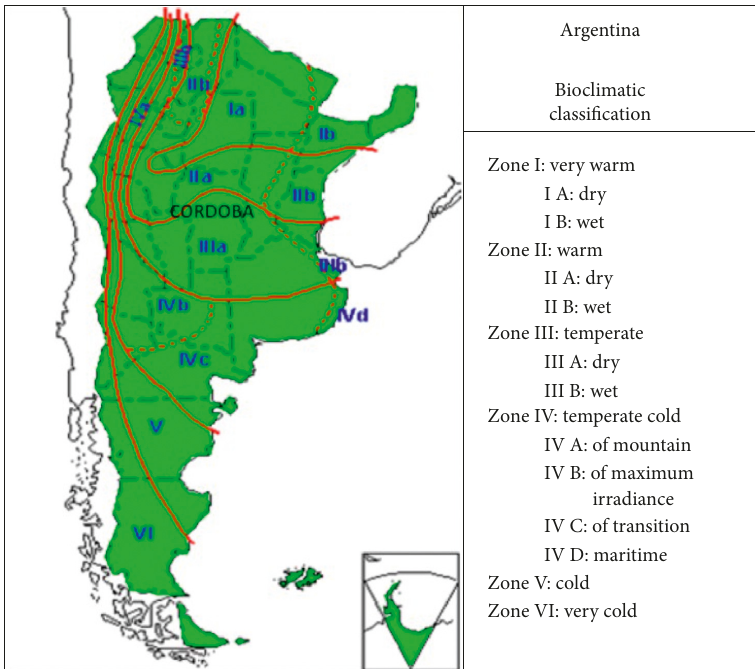
Figure 2: Bioclimatic classification of the zones of Argentina according to IRAM Standard 11603/96 [17].